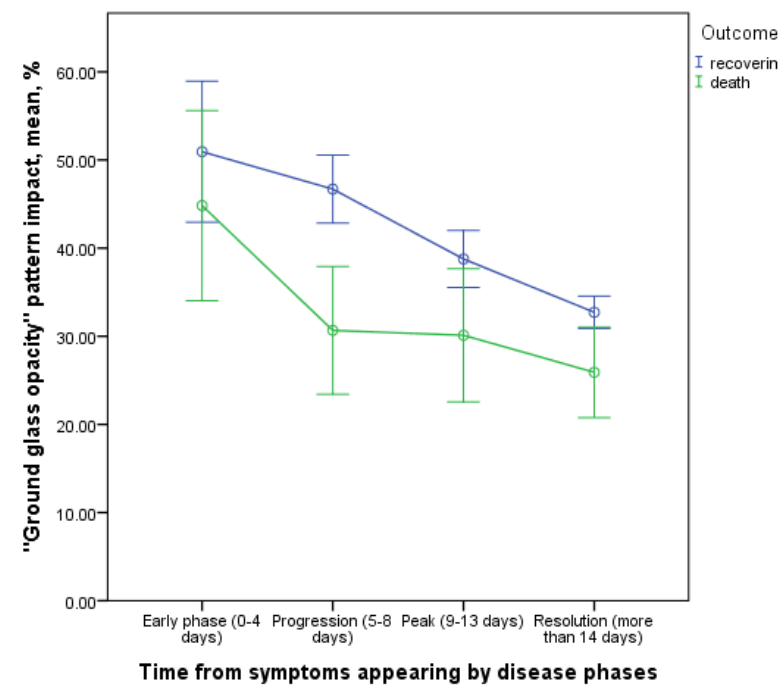
Figure 10. Contribution of the GGO pattern to CT picture in the affected